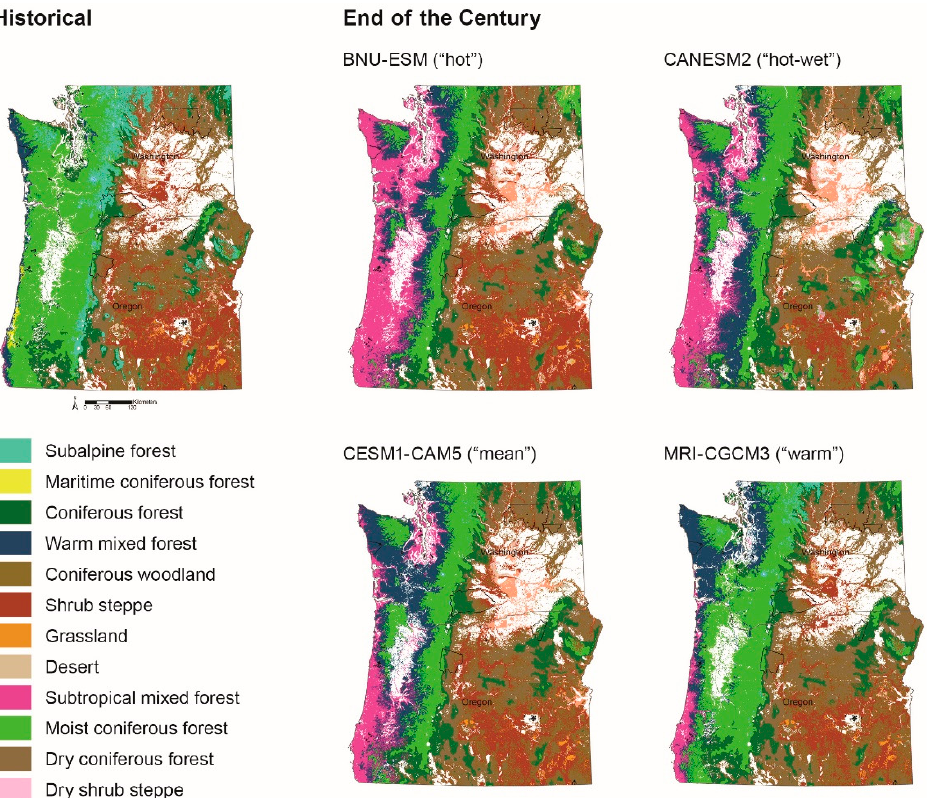
Figure 4. Historical (1970–1999) and end of the century (2070–2099) simulations of vegetation types across the study area for the BNU-ESM (“hot”), CanESM (“hot-wet”), CESM1-CAM5 (“mean”), and MRI-CGCM3 (“warm”) GCMs. Tribal reservations are delineated with black polygons.